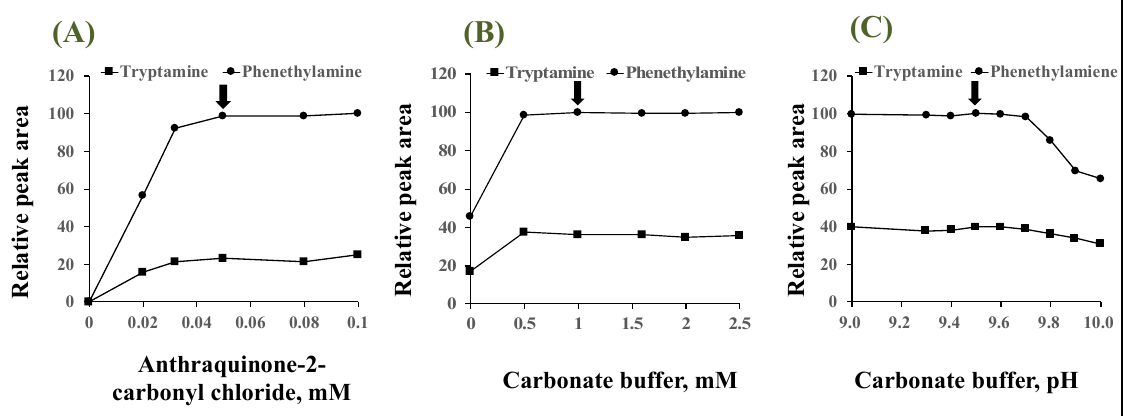
Figure 4. Effects of ( A ) anthraquinone-2-carbonyl chloride concentration, ( B ) carbonate buffer concentration, and ( C ) buffer pH on the peak area of derivative. Arrows indicate optimum conditions.